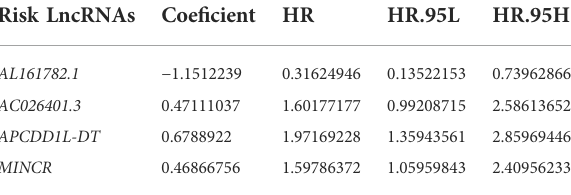
TABLE 2 Multivariate Cox regression analysis of 4 risk